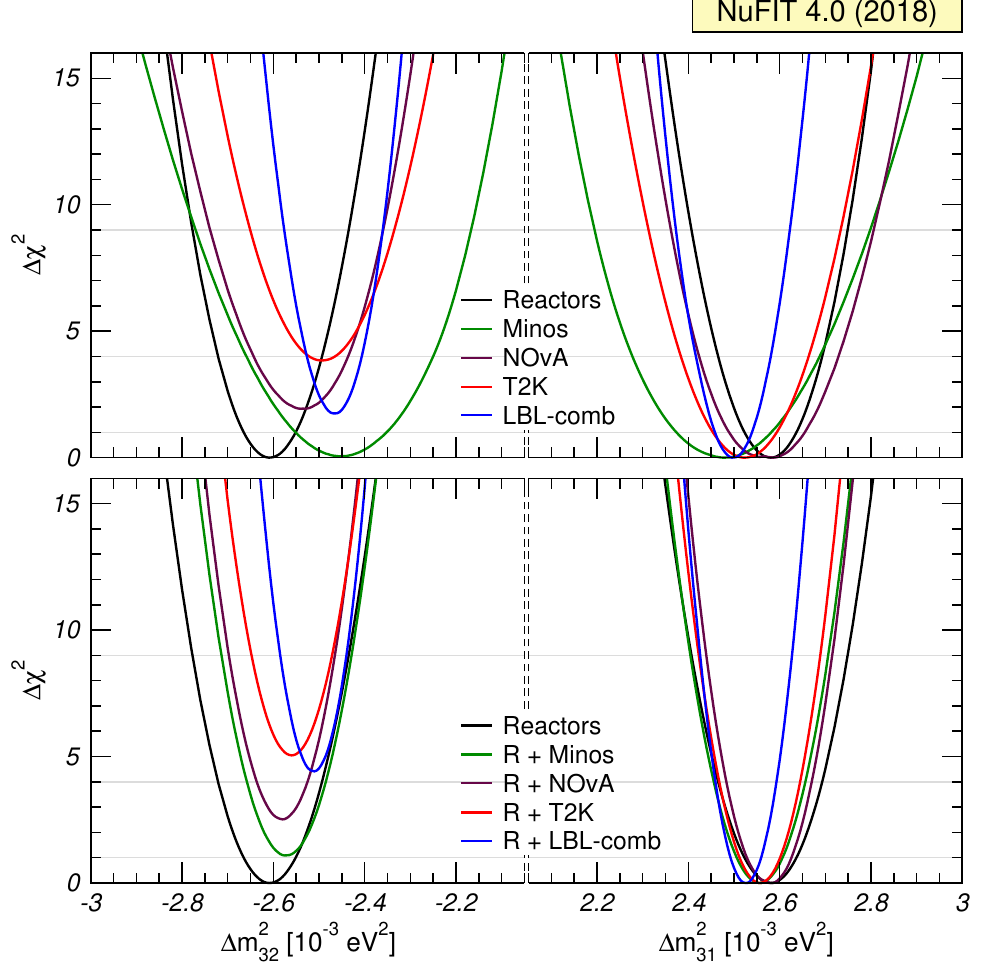
Figure 9 . (cid:1) m 2 determination from LBL, reactor and their combination. Left (right) panels are for 3 ‘ IO (NO). The upper panels show the 1-dim (cid:1) (cid:31) 2 from LBL experiments after constraining only (cid:18) 13 from reactor experiments. For each experiment (cid:1) (cid:31) 2 is de(cid:12)ned with respect to the global minimum of the two orderings. The lower panels show the corresponding determination when the full information